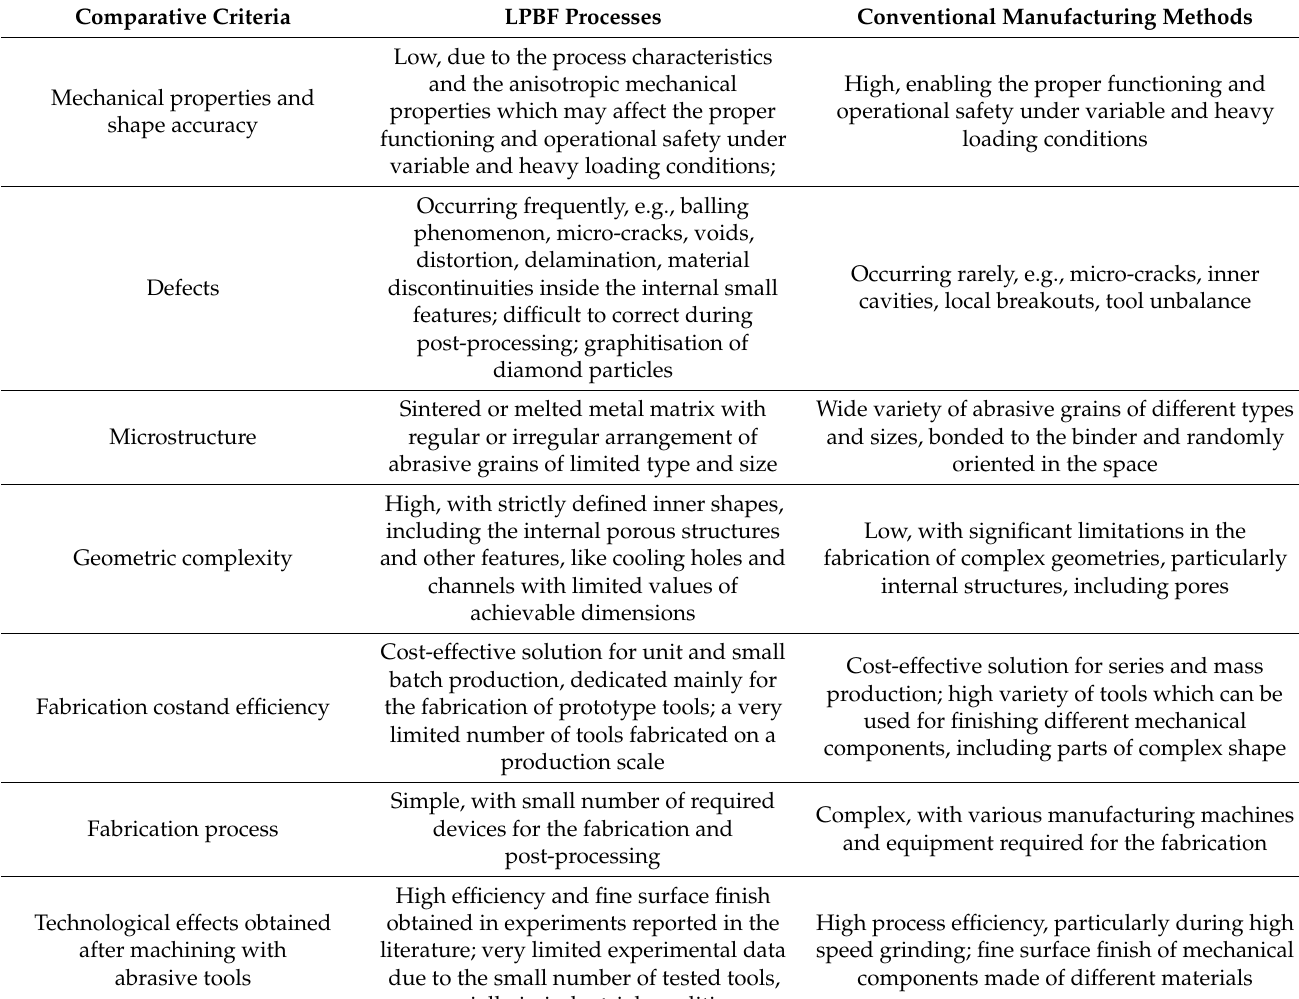
Table 2. Comparison analysis of LPBF and conventional manufacturing processes used for the fabrication of abrasive tools. Comparative Criteria LPBF Processes